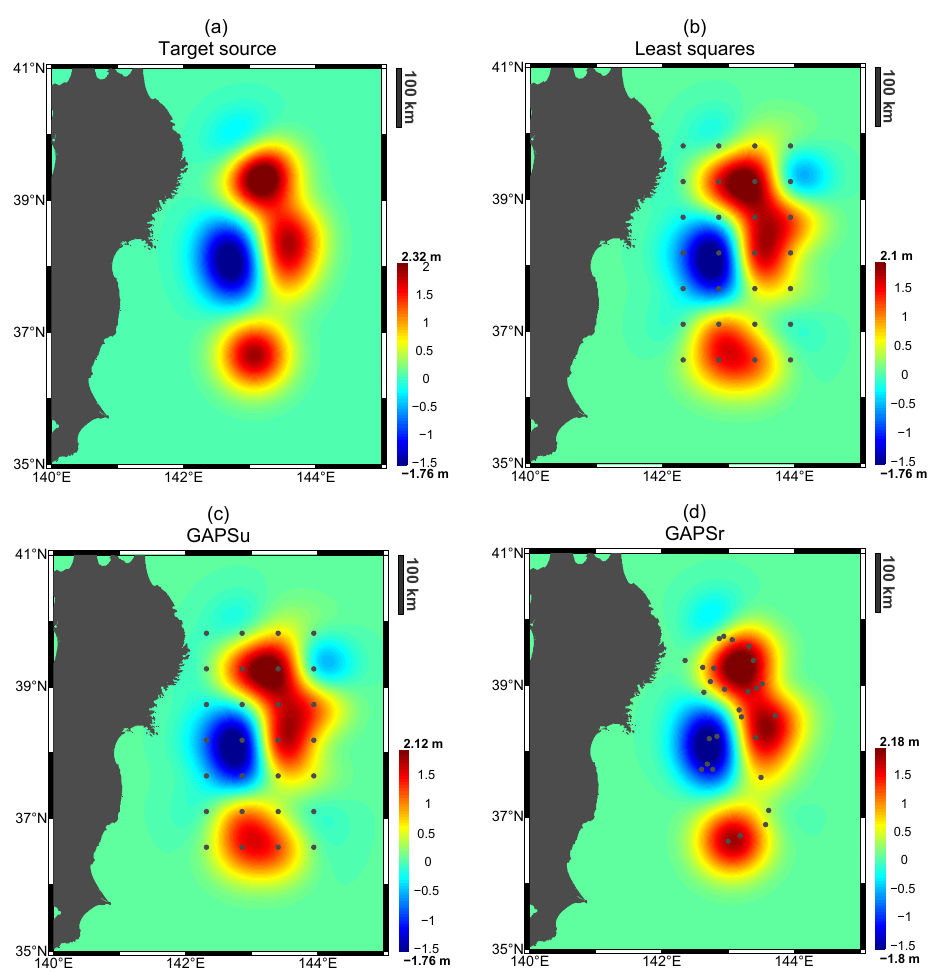
Figure 6. Sea surface deformation. Gray dots indicate the centroid of unit sources. (a) Artificial tsunami source as the target to be approxi- mated, (b) inverted source using least squares method, (c) GAPSu model, (d) GAPSr